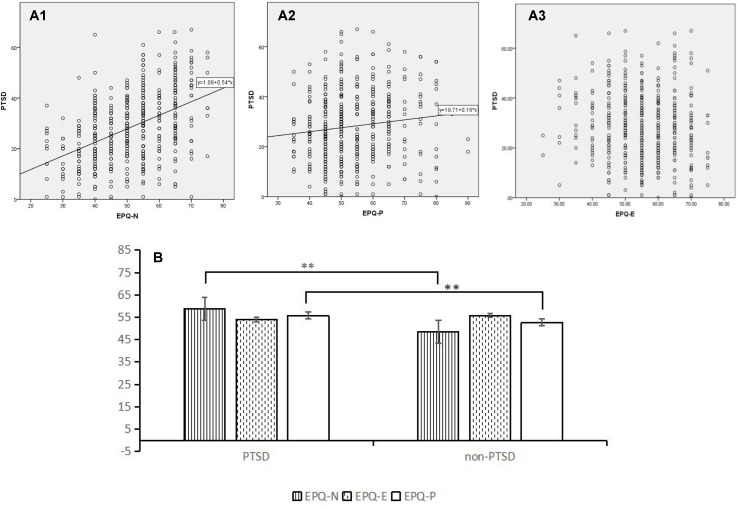
Pearson correlation coefficient analysis of the correlation between the score of EPQ and PTSD. (A1) presents the scatter plot distribution between EPQ-N and PTSD; (A2) presents that between EPQ-P and PTSD; (A3) presents that EPQ-E and PTSD. (B) shows means and standard deviations on EPQ scales between PTSD (n = 104) and non-PTSD (n = 353), divided according to the cut-off score of IES-R with the missing values filled with the average. EPQ-N, Eysenck Personality Questionnaires-Neuroticism; EPQ-E, Eysenck Personality Questionnaires-Extraversion; EPQ-P, Eysenck Personality Questionnaires-Psychoticism.